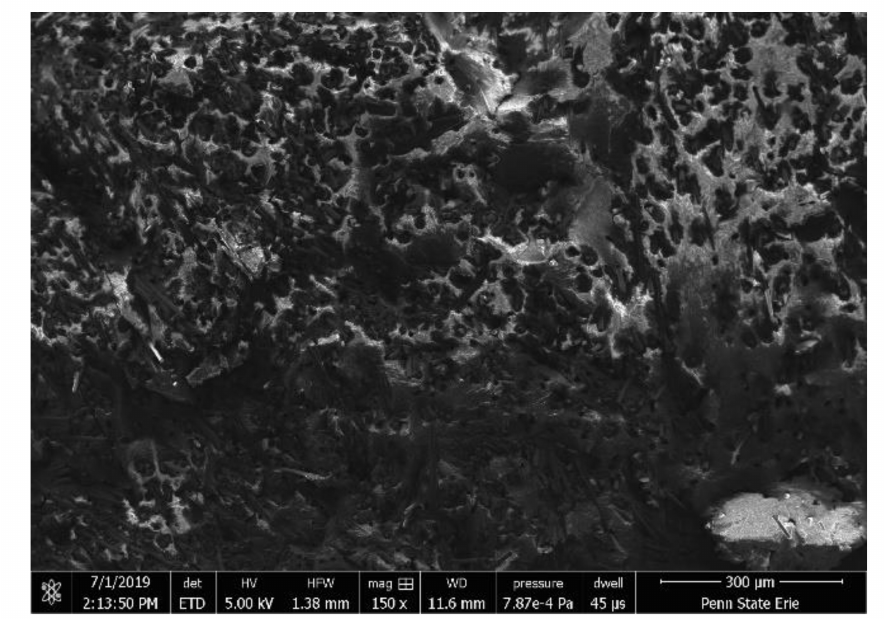
Figure 6. SEM image of the specimen with 50% CF3 showing fiber alignment near the core of the specimen.